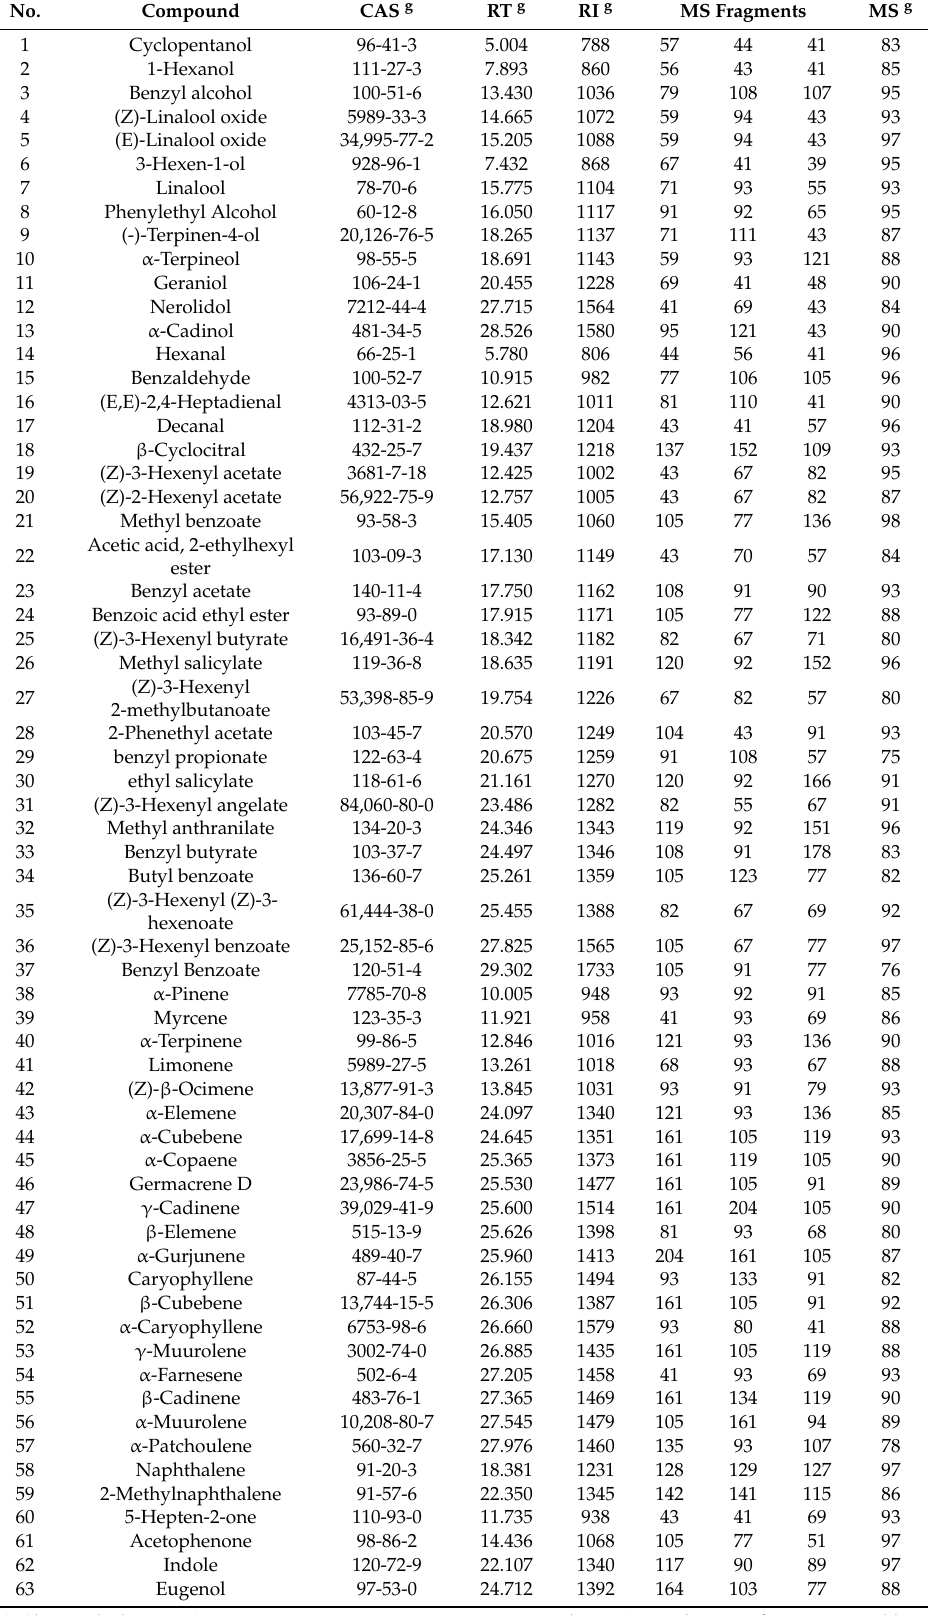
Table 1. The identification of Volatile Organic Compounds (VOC) in grade jasmine tea.